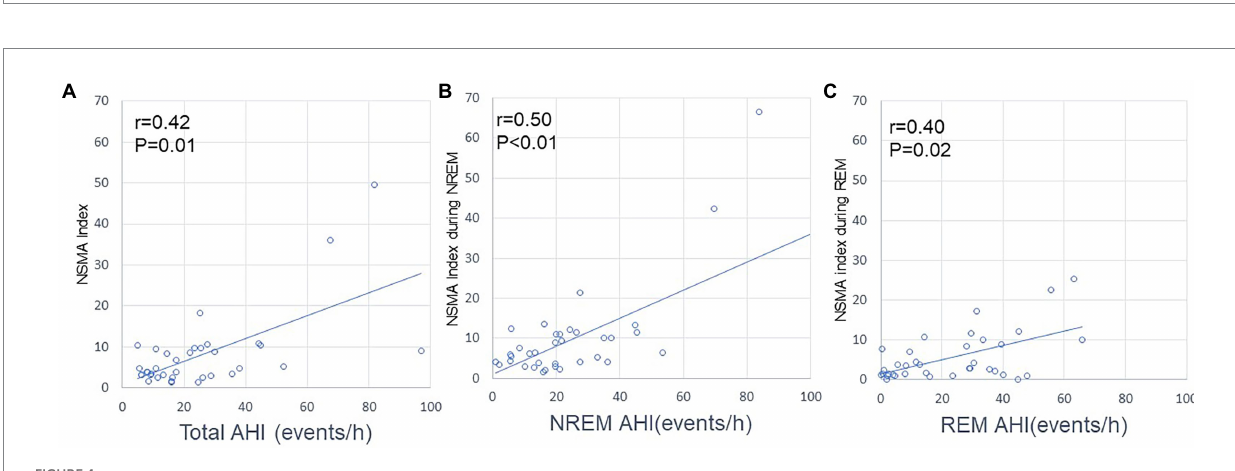
FIGURE 4 Relationships between AHI and the NSMA index. (A) Relationship between AHI and the NSMA index for the whole night. (B) Relationship between AHI and the NSMA index during NREM sleep. (C) Relationship between AHI and the NSMA index during REM sleep. The frequency of NSMA events positively correlated with that of apnea/hypopnea (Spearman’s correlation